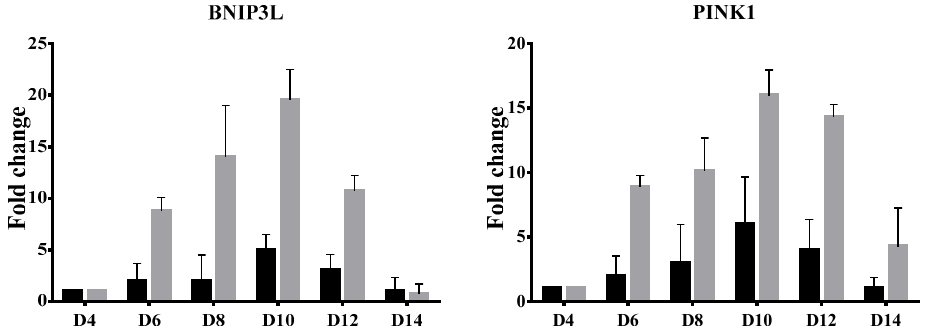
Figure 2. Quantitative RT-PCR analysis of BNIP3L and PINK1 transcripts. The mRNA levels were measured at days 4, 6, 8, 10, 12 and 14 of in vitro erythroid culture. Results from quantitative RT- PCR have been depicted as relative fold change of each day compared to day 4 with the mean and SEM value normalized to ribosomal protein S18 (RPS18) from three independent subjects of β 0 -thalassemia/HbE (gray bar) and healthy normal control (black bar).